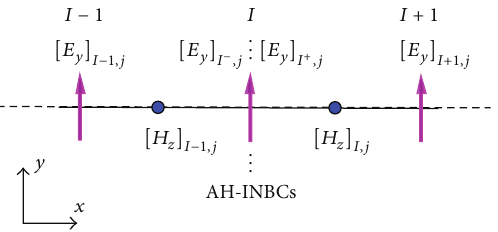
Figure 3: AH-FDTD grid for the INBC